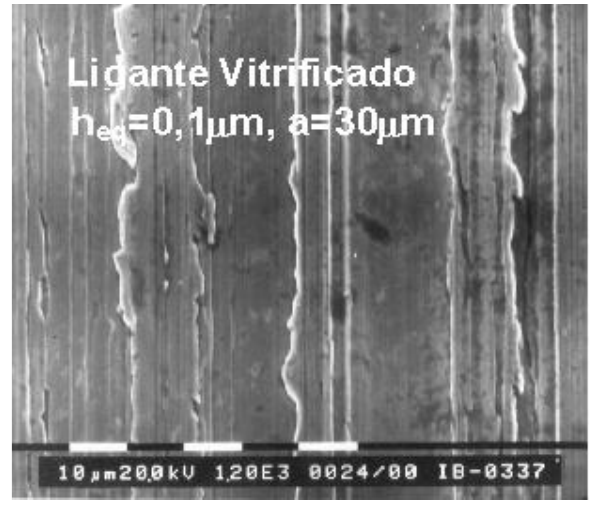
Figura 7. Ensaio 7.